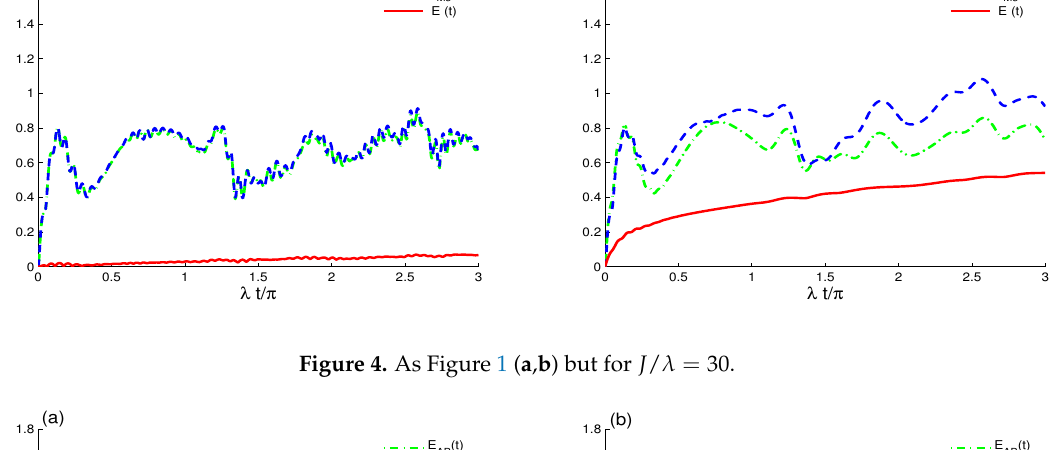
Figure 4. As Figure 1 ( a , b ) but for J / λ = 30.